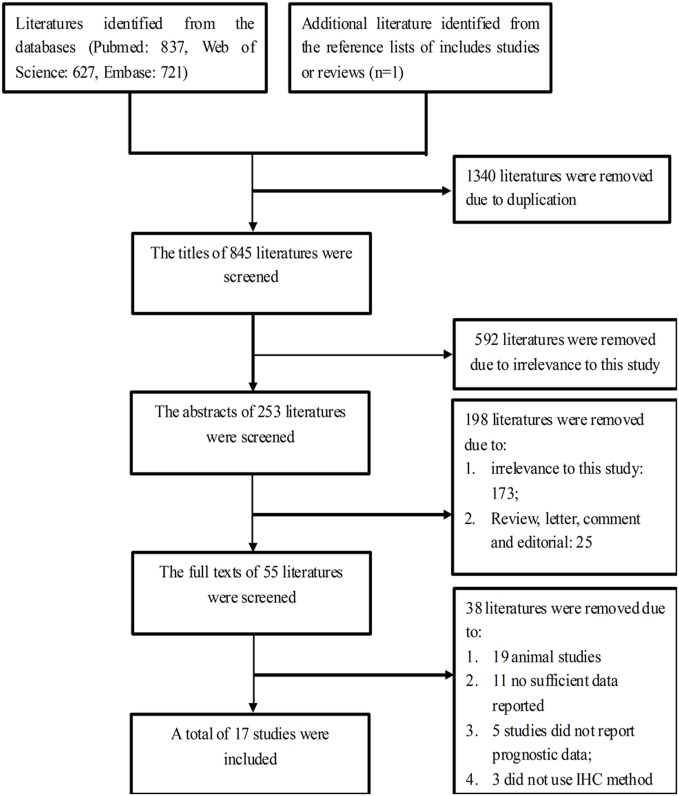
Flow chart showing the method used to select eligible studies.